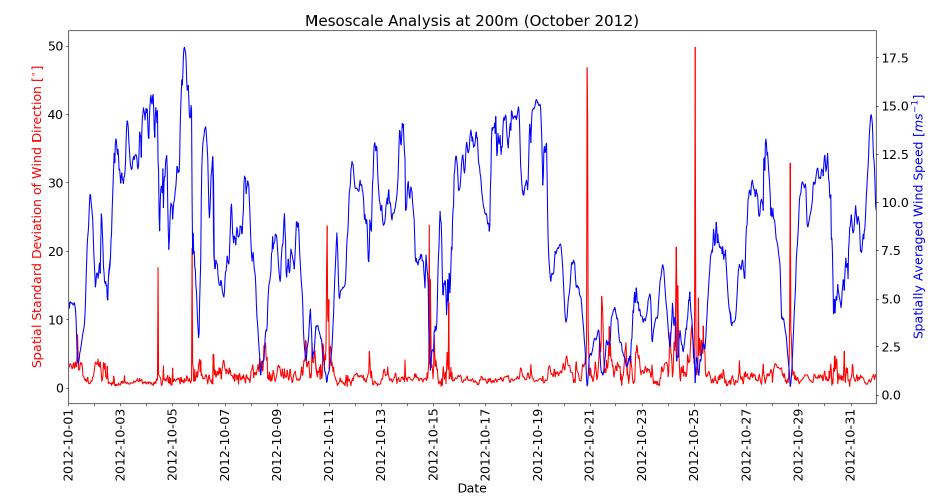
Figure 6. Spatial standard deviation of wind direction (red) and spatial average wind speed (blue) both changing with time (30 min resolution) in October 2012 at Rödeser Berg. Based on the New European Wind Atlas (NEWA)